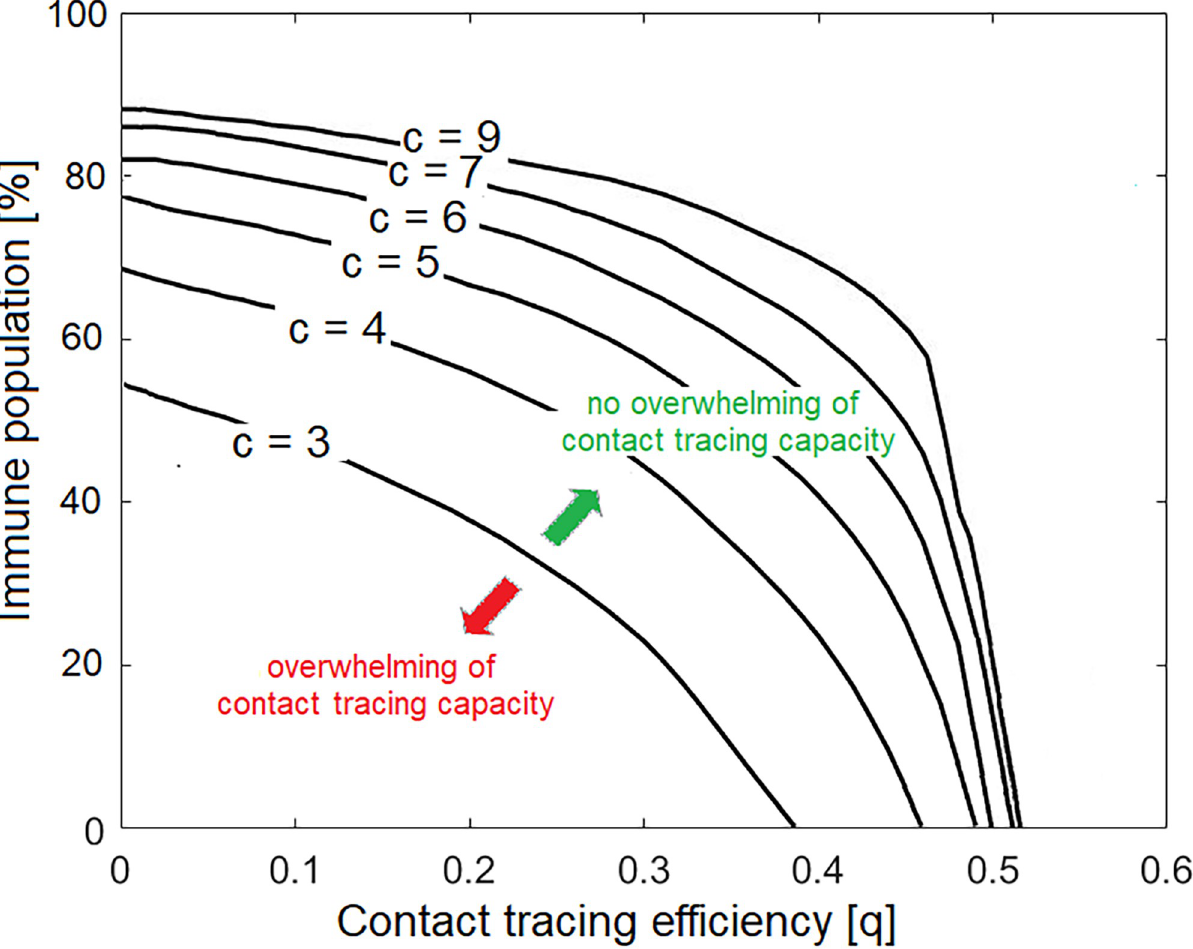
Fig 2. Contact tracing efficiency needed to avoid overwhelming contact tracing capacity, as a function of the proportion of immune individuals in a population and for different contact rates (black curves, with c = {3, 4, 5, 6, 7, 9}), for I � space for which contact tracing is overwhelmed, while the area above each curve represents the parameter space for which contact tracing is not overwhelmed. The curves represents the minimal contact tracing efficiency q � for the simulations are given in Table